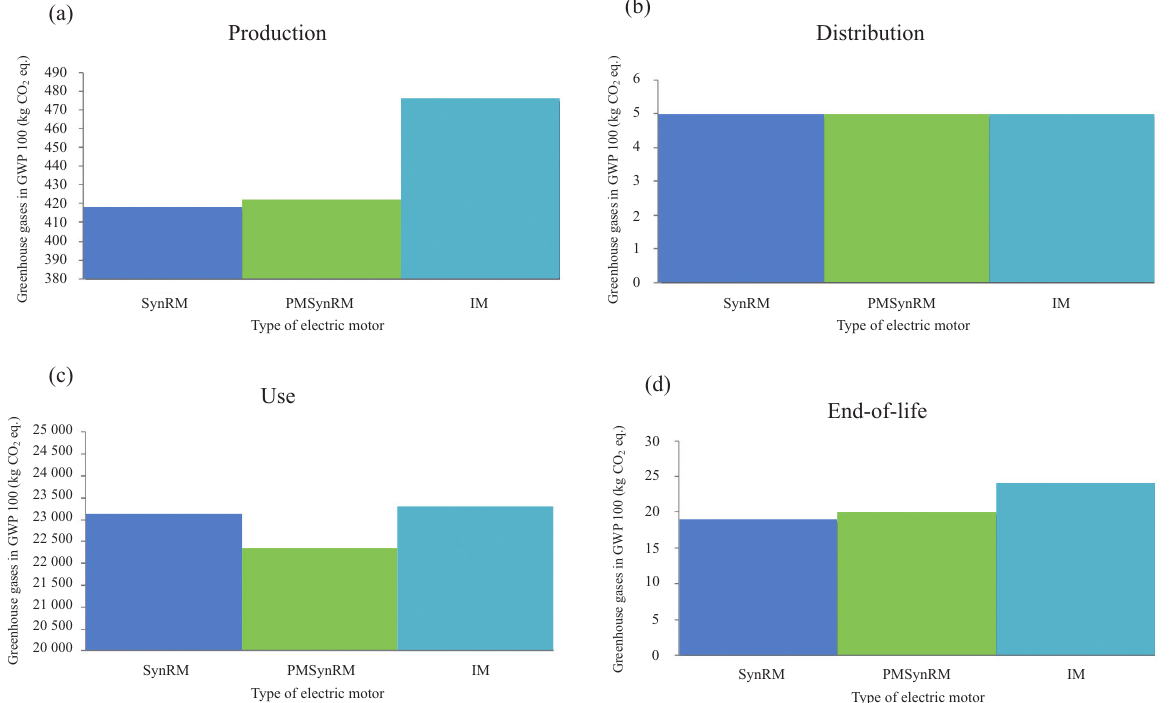
Fig. 8. Greenhouse gases vs. the type of electric motor in four life cycle stages: production (a), distribution (b), use (c) and end of life (d).